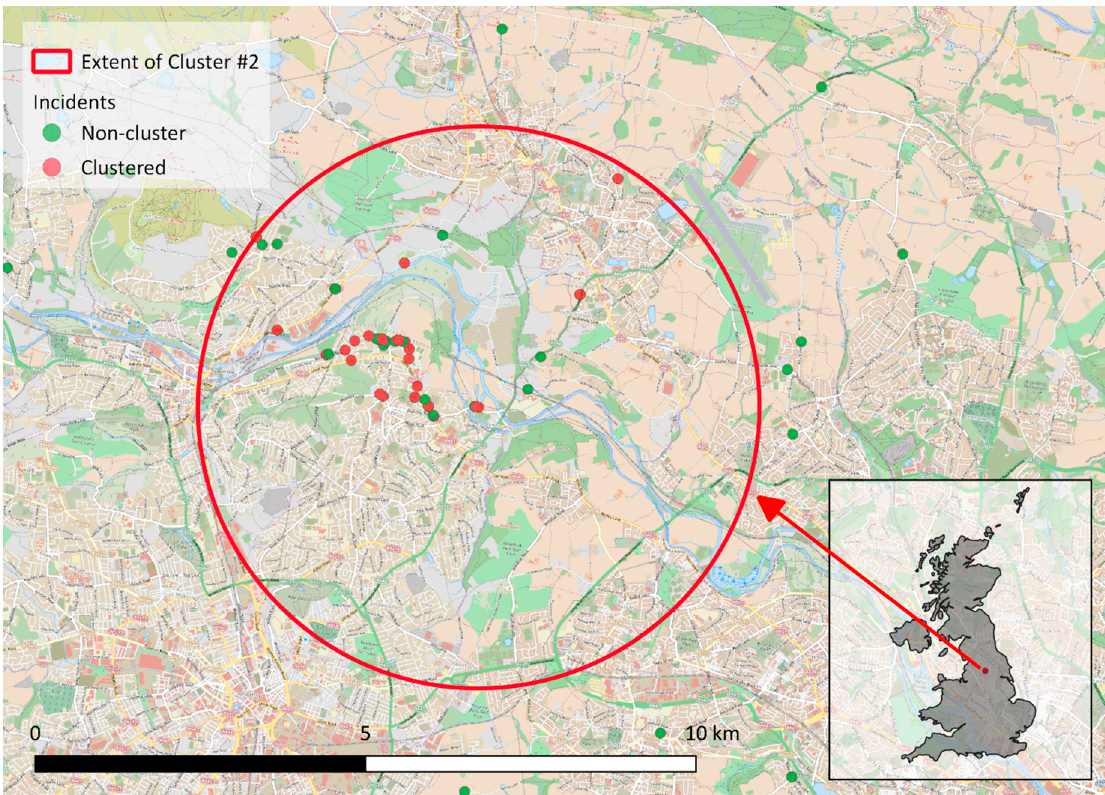
Figure 3. Cluster #2, near Leeds in Yorkshire, depicting the spatial component by the large red circle and the time component by those points that were part of the cluster in red (incidents occurred between 3 Aug 2016 until 2 June 2017) while those that are not considered clustered in green. The inset map depicts the location of Cluster #2 in relation to the United Kingdom – also refer to Figure 2b. The underlying background of the main map is the Wikipedia Bike Hike Map which is hosted by OpenStreetMap (https://www.openstreetmap.org) and available under a CC BY-SA 3.0 license (https://wiki.osmfoundation.org/wiki/Terms_of_Use).